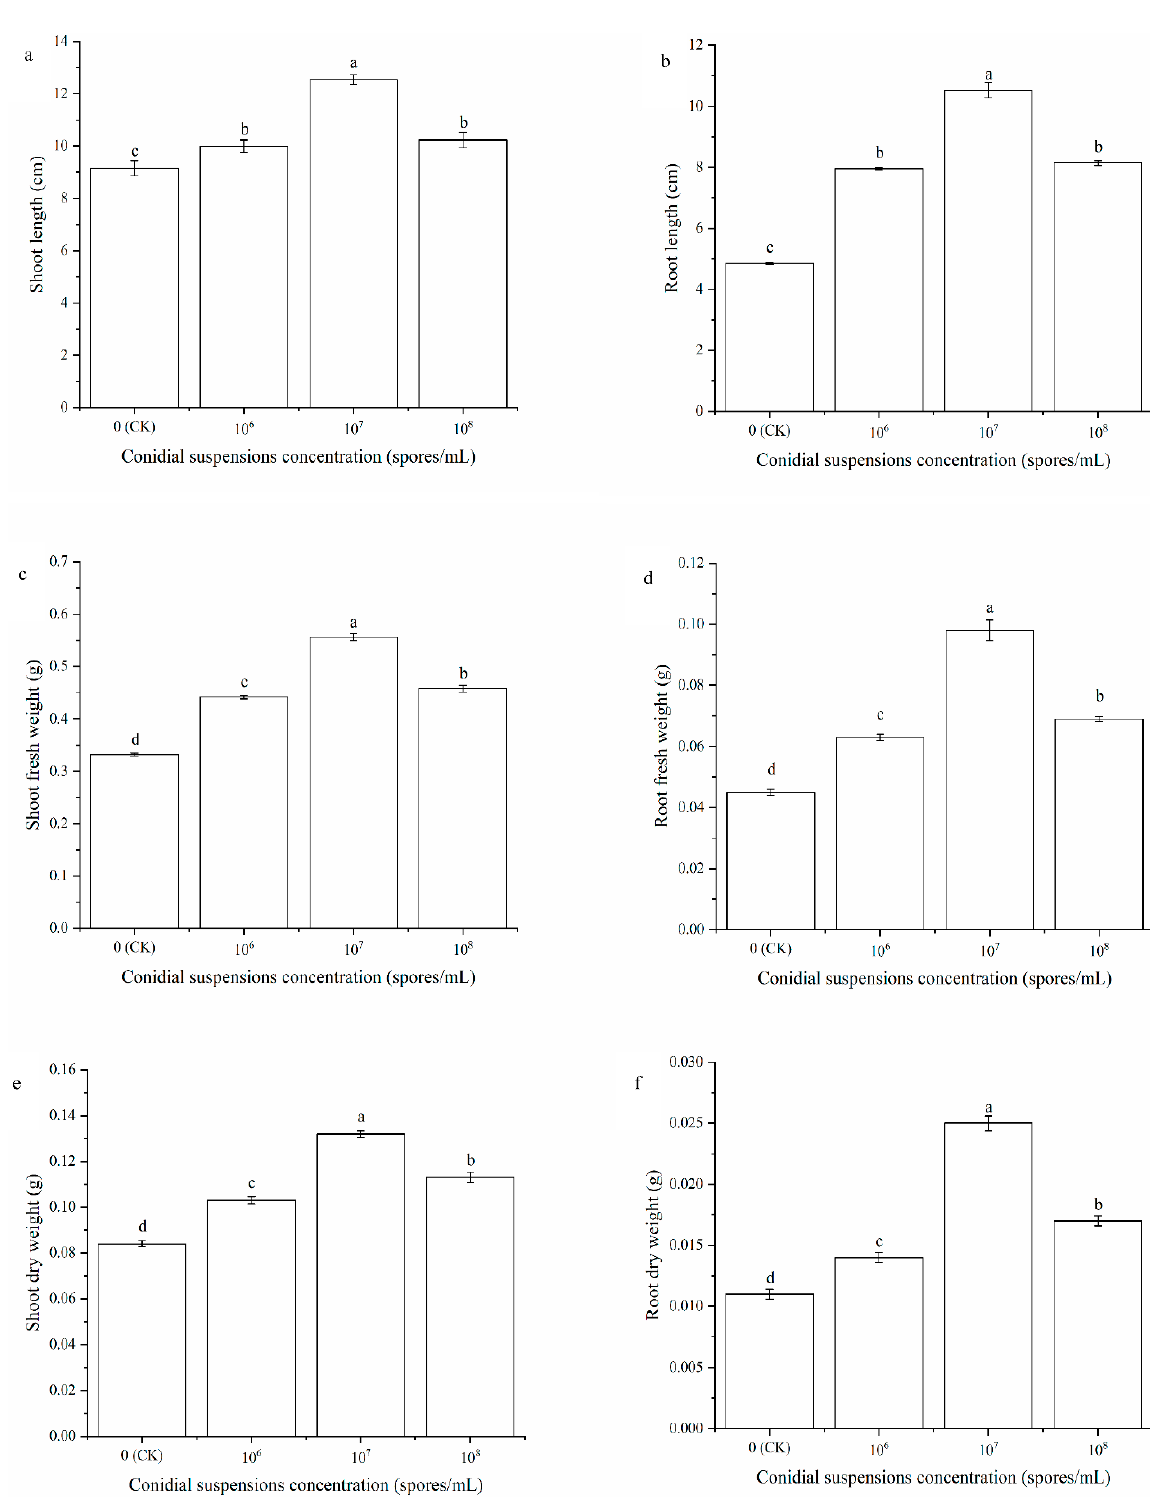
Figure 1. Effects of different concentration conidial suspensions of HT-1 strain on shoot length ( a ), root length ( b ), shoot fresh weight ( c ), root fresh weight ( d ), shoot dry weight ( e ), and root dry weight ( f ) of R. palmatum under greenhouse. Values are mean ± SD ( n = 15 plants). Different letters above the bars indicate the differences are significant at p < 0.05.